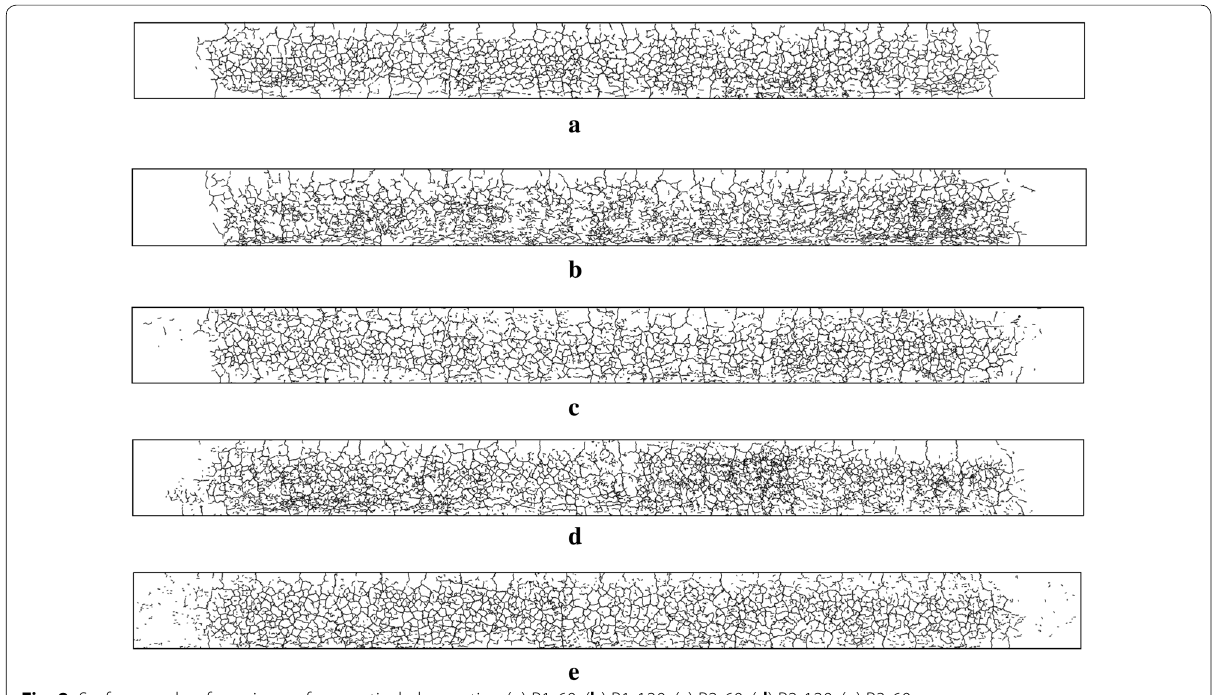
Fig. 8 Surface cracks of specimens from optical observation ( a ) P1-60, ( b ) P1-120, ( c ) P2-60, ( d ) P2-120, ( e ) P3-60.